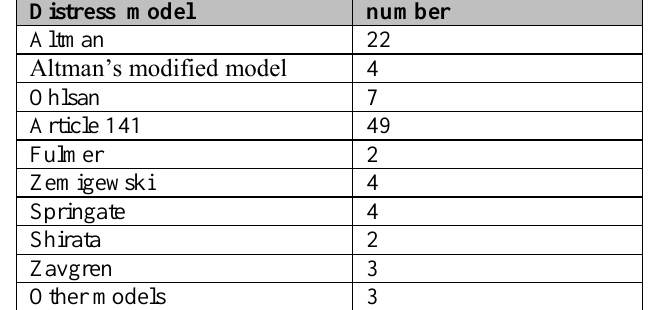
Table 2: Methods used in 100 recent researches about Bankruptcy Distress model number